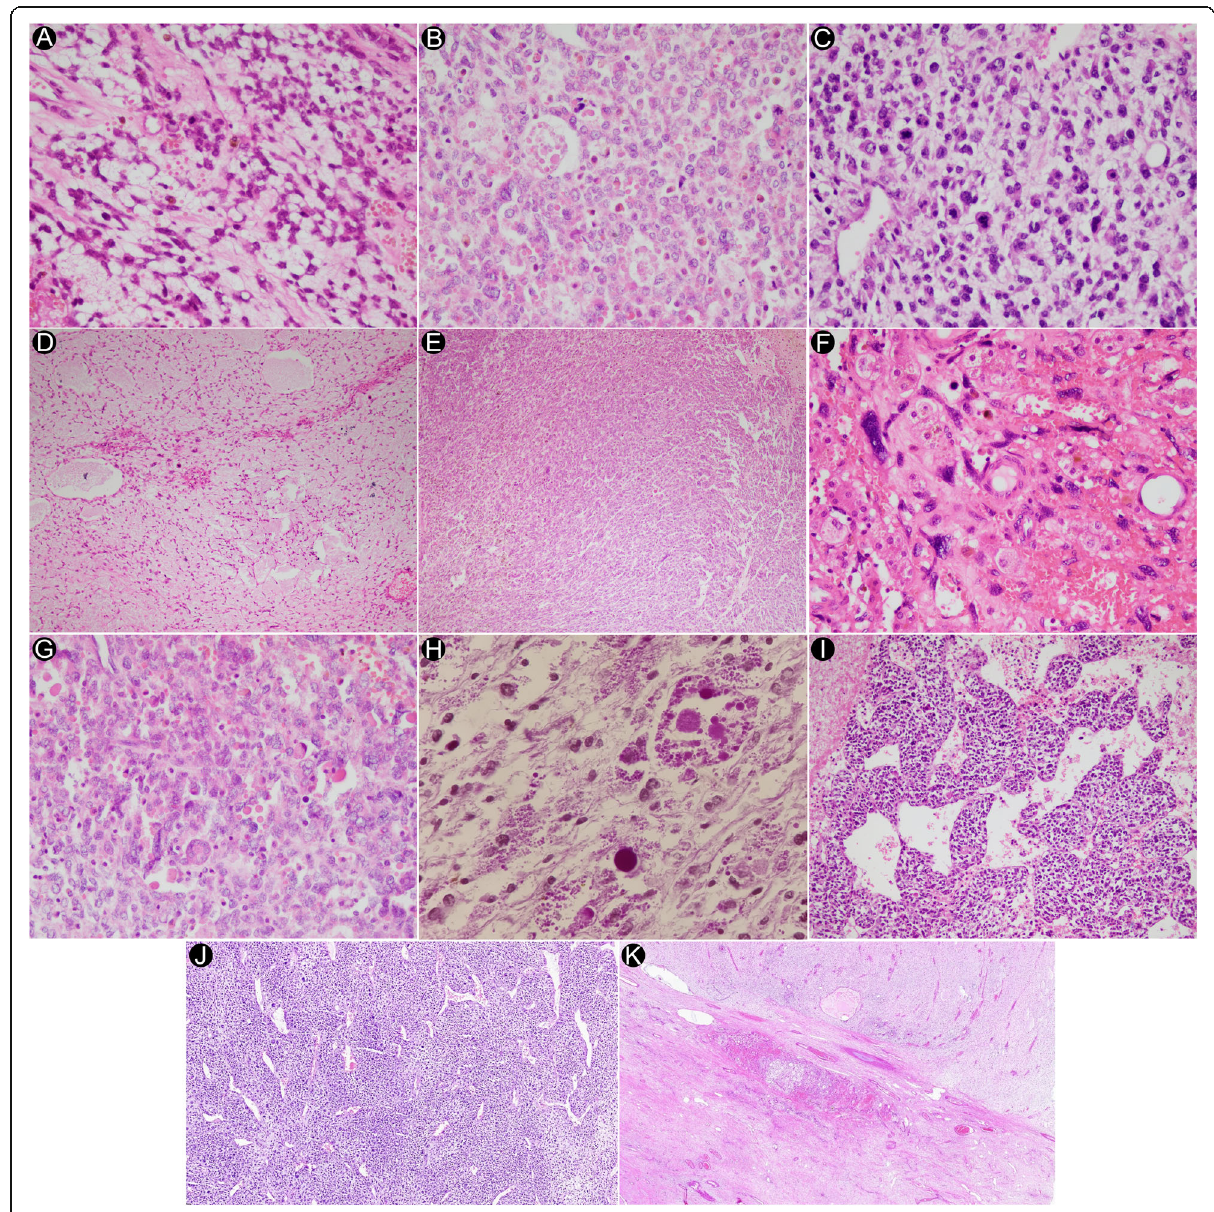
Fig. 1 Histopathologic findings in UESL cases. A Anaplastic stellate and spindle-shaped tumor cells with indistinct cytoplasmic border and light cytoplasm (Hematoxylin and Eosin, 400×). B Anaplastic epithelioid tumor cells with eosinophilic cytoplasm (Hematoxylin and Eosin, 400×). C Hyperchromatic nuclei with irregular nuclear border and multiple mitoses (Hematoxylin and Eosin, 400×). D Loosely arranged tumoral cells (Hematoxylin and Eosin, 100×). E Compactly arranged tumoral cells (Hematoxylin and Eosin, 100×). F Bizarre and multinucleated tumor cells with highly atypical nuclei (Hematoxylin and Eosin, 400×). G Multiple variably-sized eosinophilic hyaline globules (Hematoxylin and Eosin, 400×). H Periodic acid-Schiff diastase resistant-positive hyaline globules (400×). I Collections of small round cells (Hematoxylin and Eosin, 200×). J Hemangiopericytomatous pattern (Hematoxylin and Eosin, 40×). K Section from liver mass showing embryonal sarcoma at the top and mesenchymal hamartoma at the bottom (Hematoxylin and Eosin,